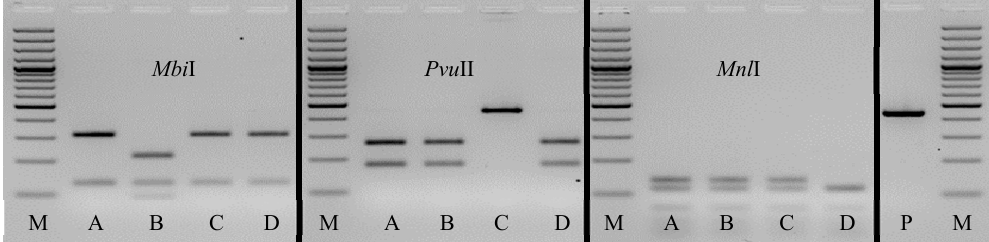
Figure 2. Examples of cleaved amplified polymorphic sequence (CAPS) analysis for detection of different Pinb alleles. M—molecular weight marker; A— Pinb-D1a ; B— Pinb-D1b ; C— Pinb-D1c ; D— Pinb-D1d ; P—undigested 447 bp PCR product.